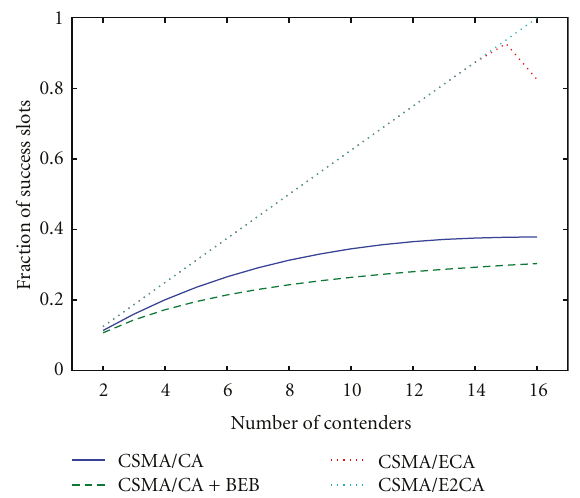
Figure 7: Fraction of success slots for each of the three protocols under comparison for di ff erent number of contenders.